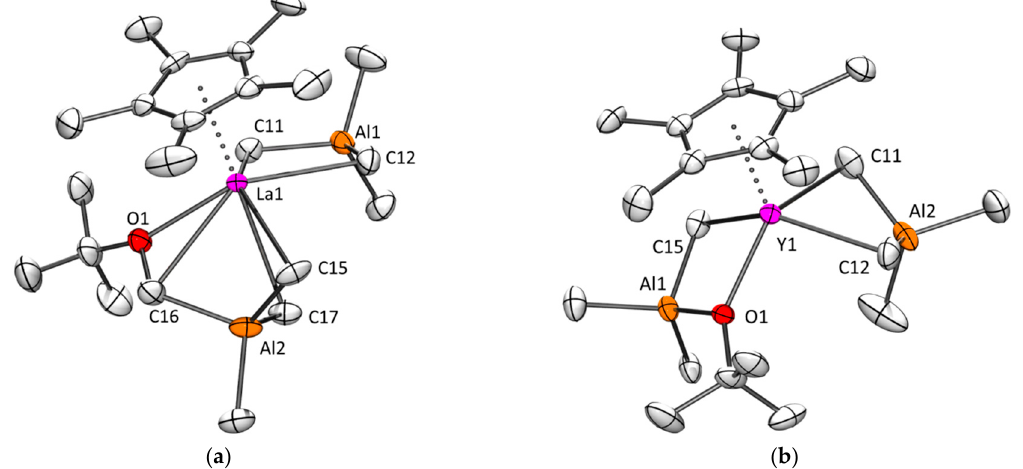
Figure 12. ORTEP view of the crystal structures of [Cp*La(AlMe 4 ){Me 3 Al(CH 2 )O t Bu}] ( 7 La , ( a )) and of [Cp*Y(AlMe 4 )(Me 3 AlO t Bu)] ( 8 Y , ( b )). Atomic displacement parameters are set at the 50% probability level. Hydrogen atoms and in both cases a second species of the respective complex per asymmetric unit are omitted for clarity. Significant lengths (Å) and angles (°) for 7 La : La1–C Cp* : 2.781(5)–2.801(6); La1–Ct: